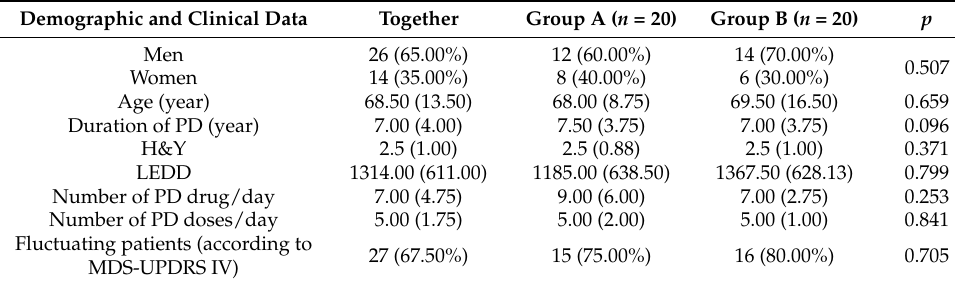
Table 1. Descriptive statistics of basic demographic and clinical data.